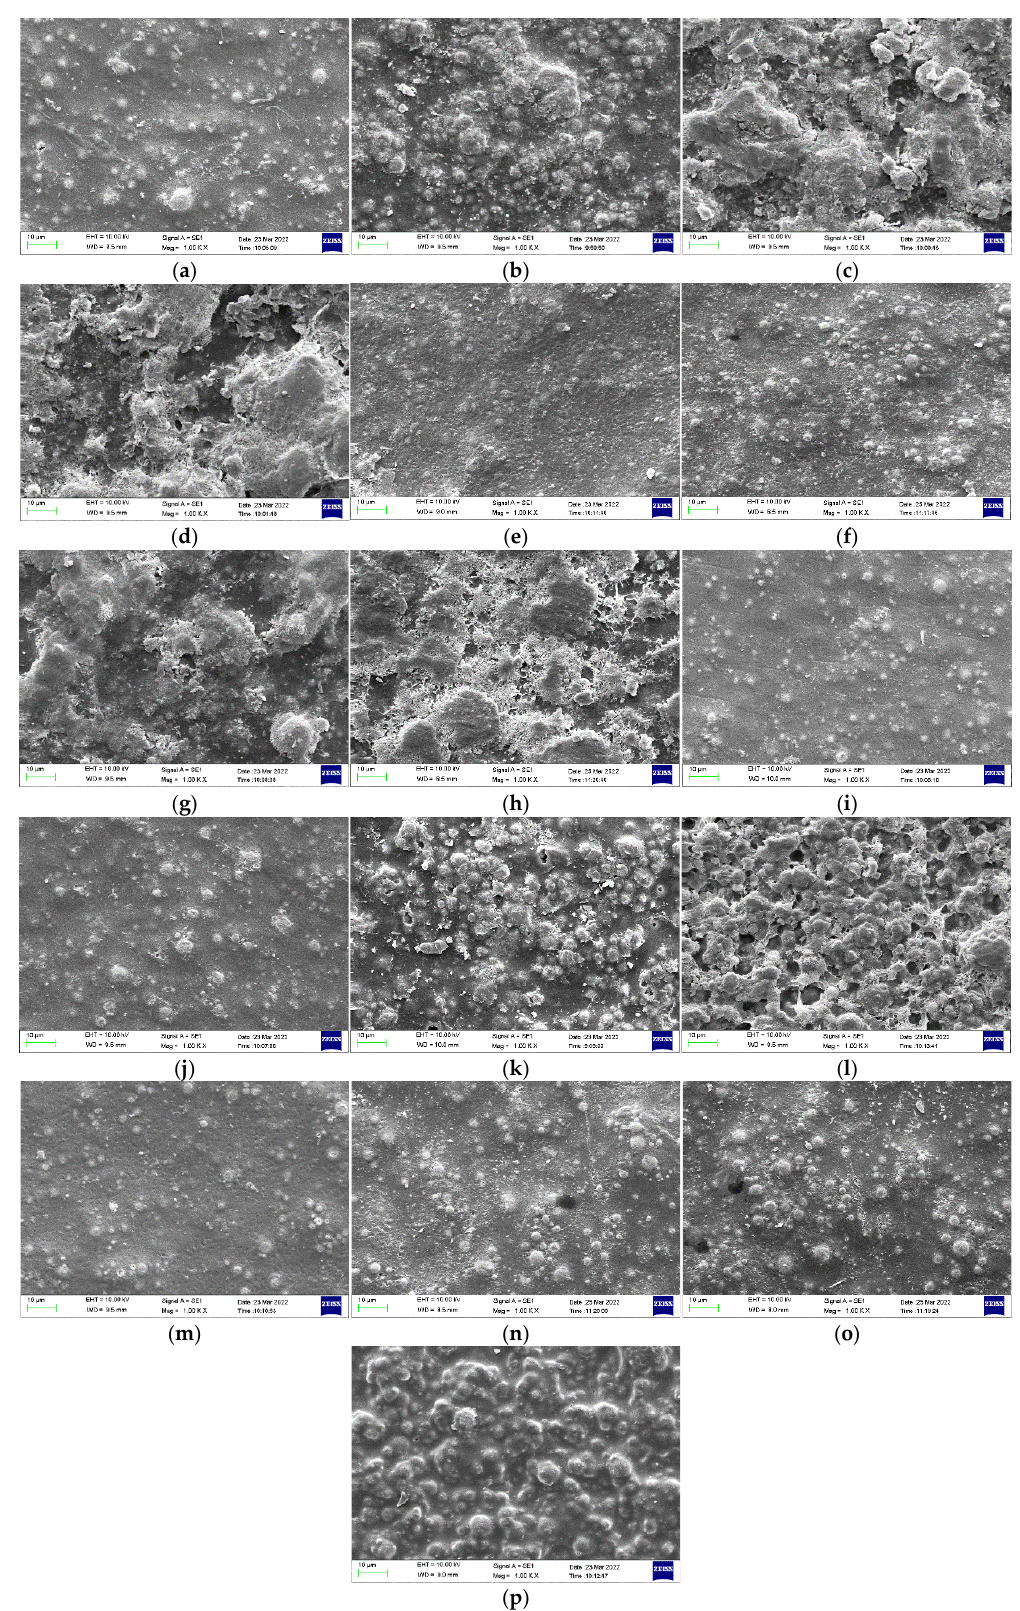
Figure 4. SEM images of W-B EZRC, PANI/W-B EZRC, GO/PANI-3/W-B EZRC, CGO/PANI-3/W-B EZRC soaked in 3.5 wt% NaCl for 0 ( a , e , i , m ), 4 ( b , f , j , n ), 10 ( c , g , k , o ), 28 ( d , h , l , p ) days.